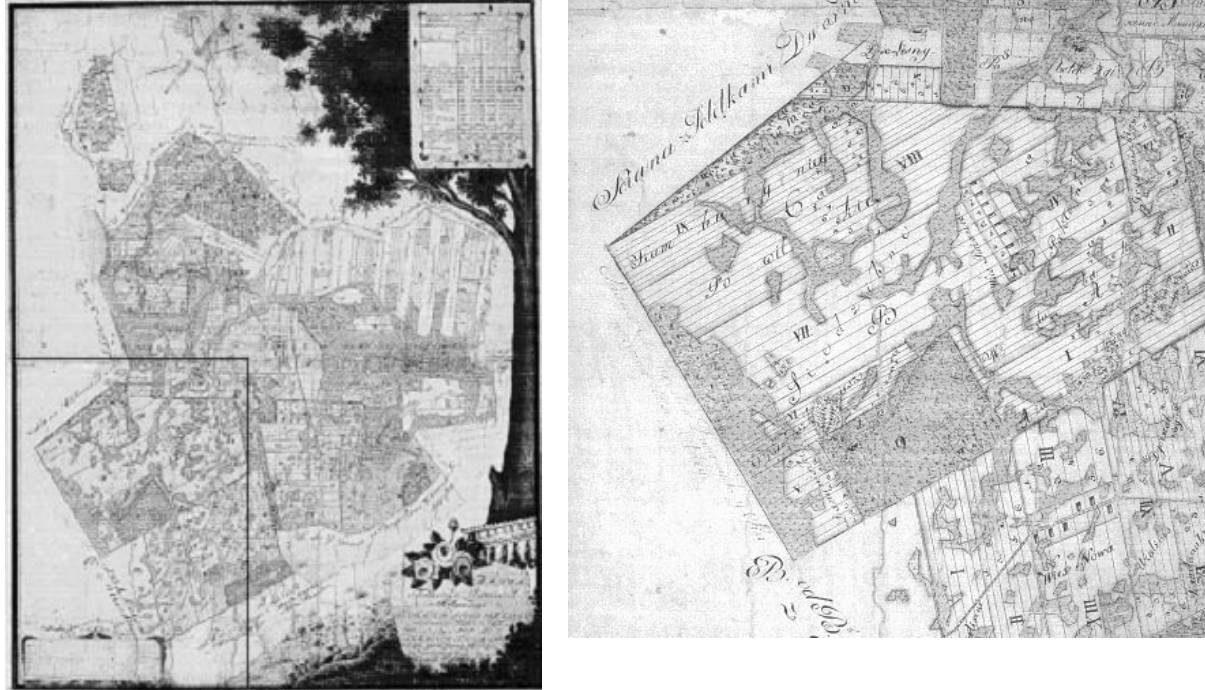
Fig 1. The plane of land estates of Litvinišk ė s in Rokiškis county, scale 1:12 600 (decreased by 6,4 times) and a fragment of the plan (decreased by 1,8